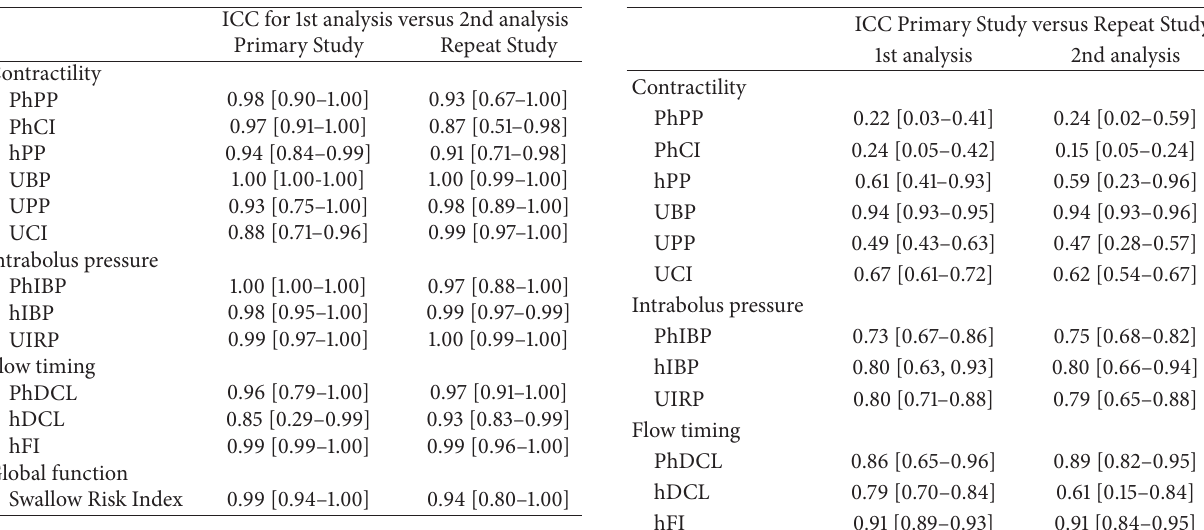
Table 1: Intrarater reliability of 1st analysis versus 2nd analysis for the Primary and Repeat Studies. Data are average ICC [range ICC].